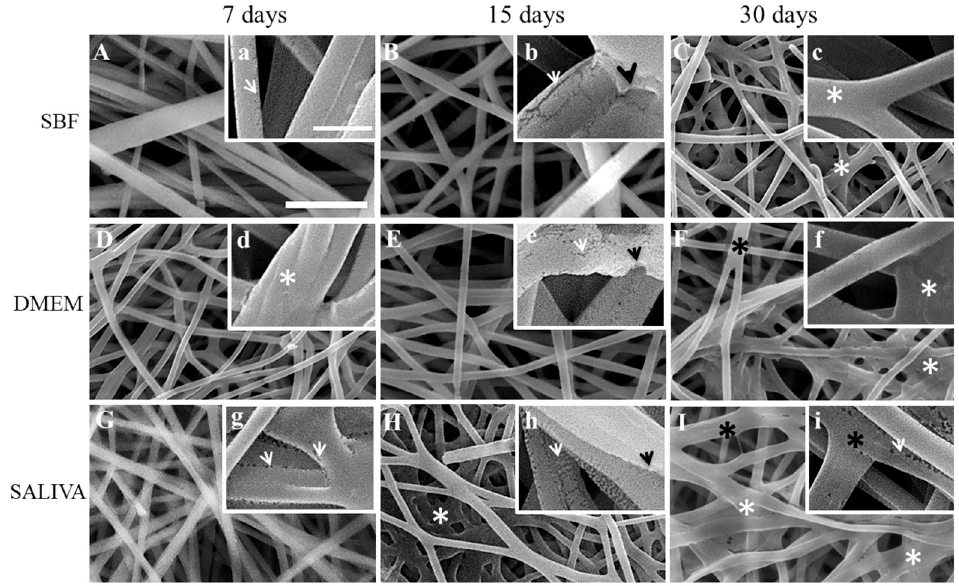
Figure 3. Representative SEM micrographs of irradiated electrospun PLGA after immersion in SBF, DMEM and saliva for 7, 15 and 30 days. Scale bars: ( A – I ) = 5 µm; ( a – i ) = 1 µm. Membrane immersed in SBF for 7 days showed fibers with border fissures. ( a, arrow ); Elongated fissures were seen in different regions of fibers after 15 days of immersion in SBF ( b, white arrow ) and also erosion areas ( b, black arrow ); after 30 days of immersion in SBF, fibers became in more contact to each other ( C, c, asterisk ). Morphology of fibers after immersion in DMEM for 7 days shows different directions of fibers and connections to each other ( d, asterisk ); After 15 days of immersion in DMEM, fibers showed surface fissures ( e, white arrow ) and erosion areas ( e, black arrow ). Morphology of fibers after 30 days of immersion in DMEM showed coalescence areas ( F,f, white asterisks ) and also connected fibers ( F, black asterisks ). Fibers showed border fissures after 7 days of immersion in saliva ( g, white arrow ); after 15 days, fibers showed increased border and surface fissures ( h, white arrow ) and erosion areas ( h, black arrow ); after 30 days of immersion in saliva, fibers showed scarce border fissures ( i, white arrow ), coalescence areas among fibers ( I, white asterisks ) and also fibers junctions ( I,i, black asterisks ).